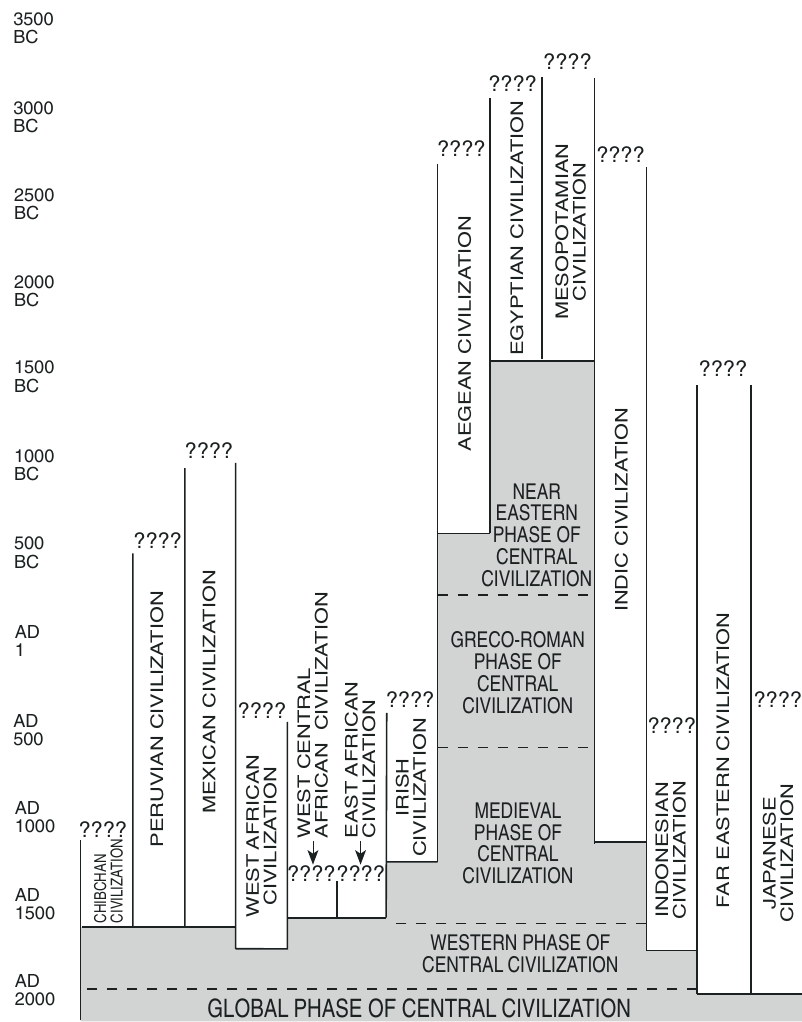
Figure 1 is a chronogram which begins at the top of the page. As one goes downward on the page, and forward in time, entities begin to appear on the chart. These are the classic or primary civilizations or world systems,